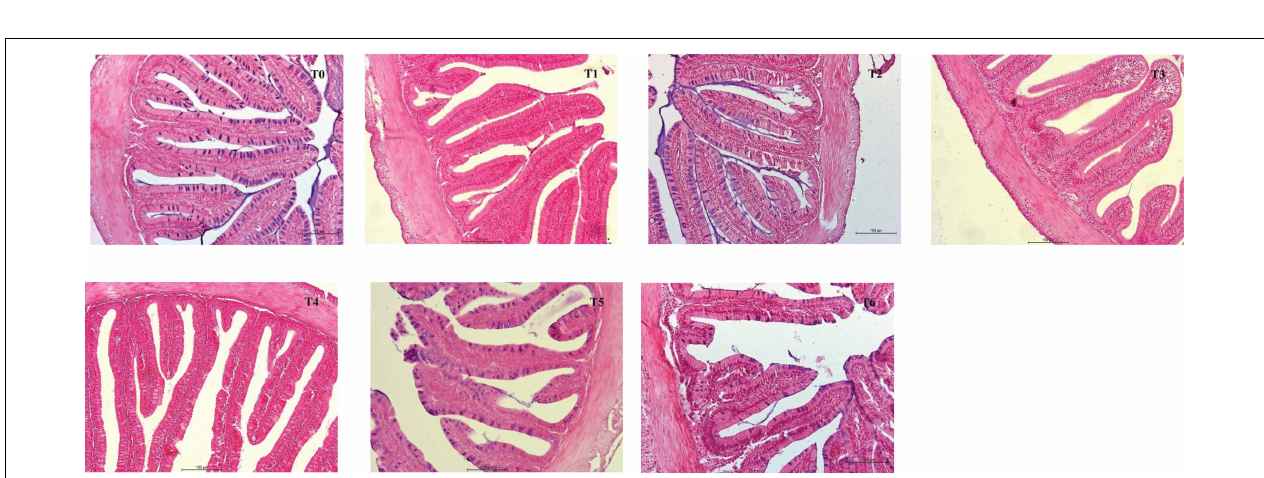
FIGURE 1 | The foregut morphological images from H&E-stained section of E. coioides fed the experimental diets for 28 days (100 × ).